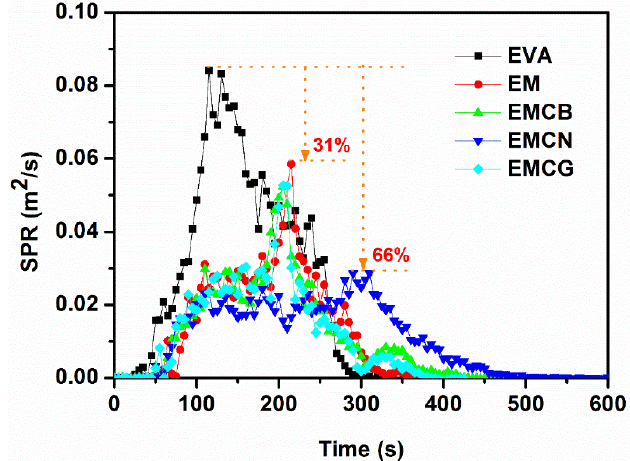
Figure 5. Smoke production rate of EVA and its composites measured by cone calorimeter at an external radiant flux of 50 kW/m 2 .